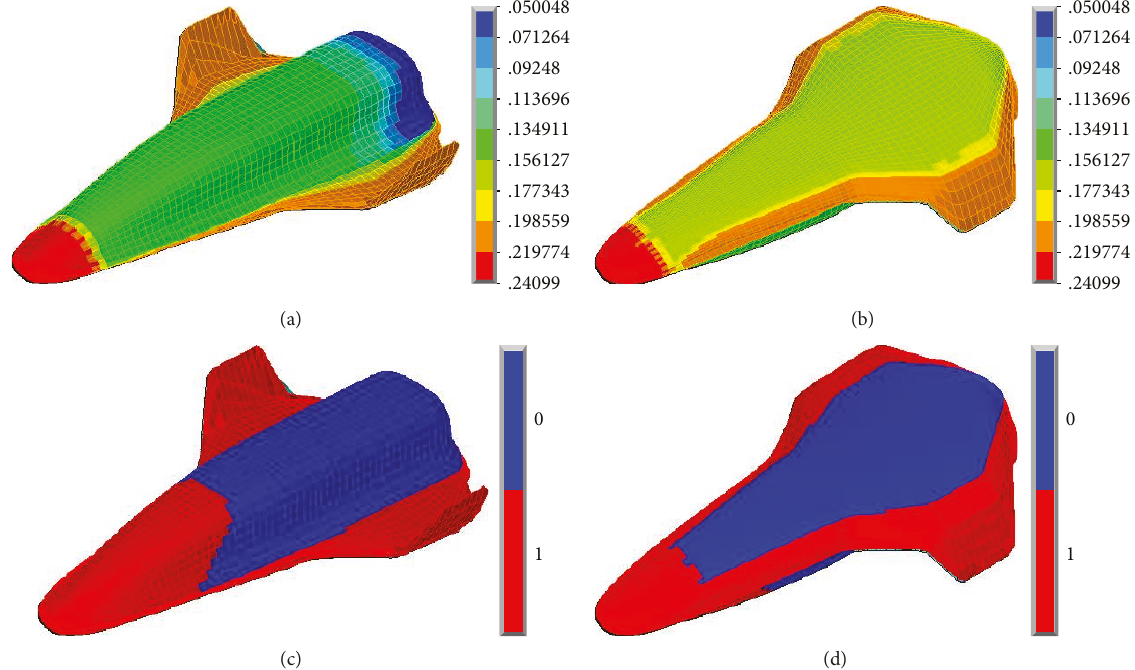
Figure 5: Example of thickness and material distribution over the RLV con fi guration (RLV-1): (a, b) thickness modulation (m); (c, d) two material maps (blue/red color indicates material “ 0 ” / “ 1, ”